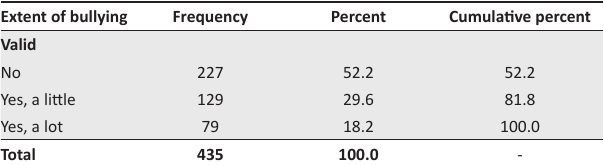
TABLE 2: Frequencies of the groups formed regarding the extent of being bullied at school. Extent of